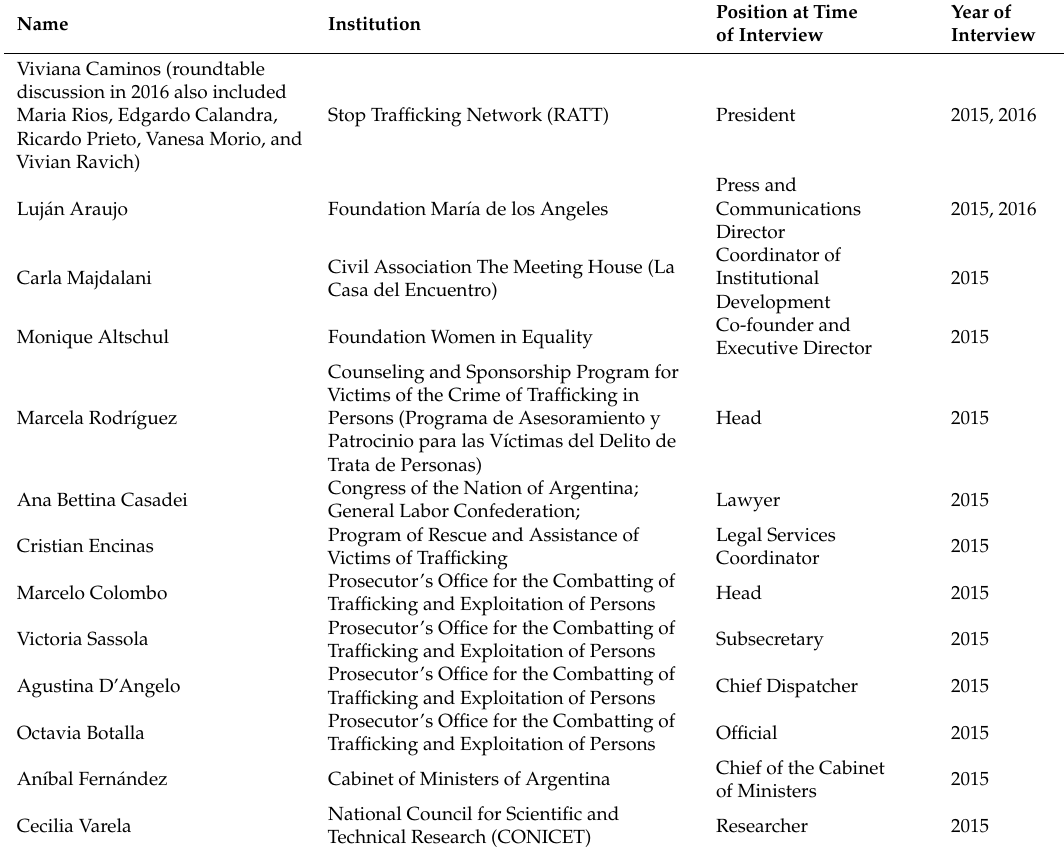
Table A3. Interviews with NGOs, government officials, and other actors in Buenos Aires,